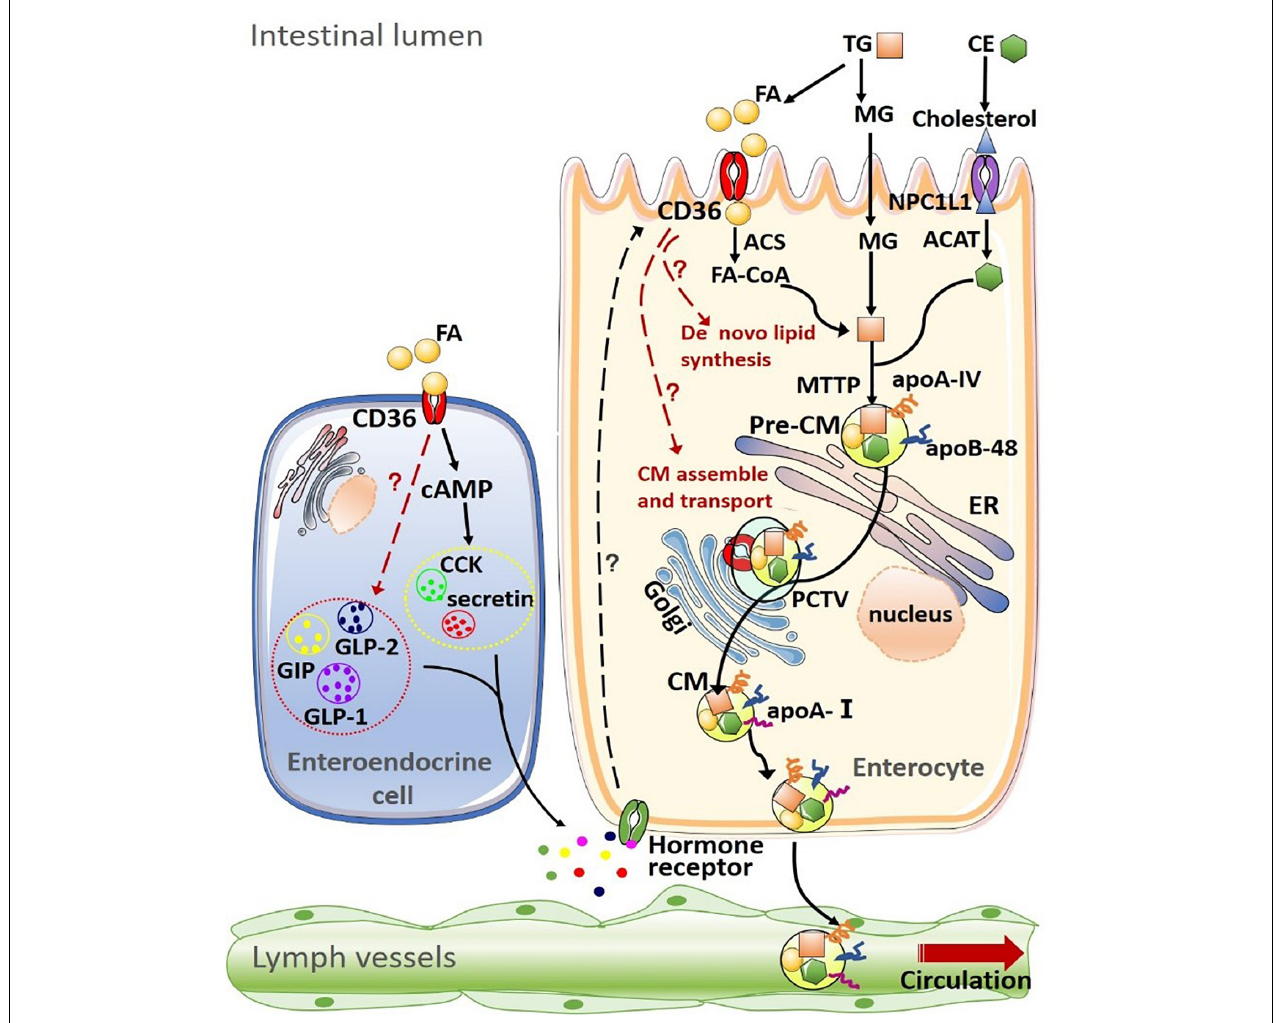
FIGURE 1 | Summary of CD36 on lipid uptake, de novo synthesis transport and intestinal hormone in the intestine. (1) Dietary lipids, such as triglyceride (TG) and cholesteryl esters (CE) are completely digested by pancreatic enzymes in the intestinal lumen, producing fatty acids (FAs), monoacylglycerols (MAGs), cholesterol. The uptake of FAs and MAGs into the enterocyte can be driven by the concentration gradient or facilitated by other proteins such as CD36. Cholesterol uptake is mediated by Niemann-Pick C1-like 1 (NPC1L1) protein. After being taken up by enterocytes, products of lipid digestion are re-esterified by a well-coordinated group of proteins [including acyl-CoA synthetase (ACS) and acyl-CoA:cholesterol acyltransferase (ACAT)] and assembled into TG and CE. Intestinal lipids are then packaged into pre-chylomicrons (pre-CM) with apolipoprotein A-IV (apoA-IV) and apolipoprotein B-48 (apoB-48) or stored as intracellular lipid droplets. Microsomal triglyceride transfer protein (MTP) mediates the packaging of lipids into pre-CM, which are transported from the endoplasmic reticulum to the Golgi apparatus for maturation via the pre-chylomicron transport vesicle (PCTV). Mature chylomicrons (CM) are then secreted into intestinal lymph trunk and transported by the lymphatic system into the circulation. (2) CD36 on the enteroendocrine cell (EEC) mediates the secretion of multiple intestinal hormones, including cholecystokinin (CCK), secretin, glucose-dependent insulinotropic polypeptide (GIP), glucagon-like peptide-1 (GLP-1), and glucagon-like peptide-1 (GLP-2). In turn, these intestinal peptides/hormones act on their receptors on enterocytes to modulate CD36 expression and